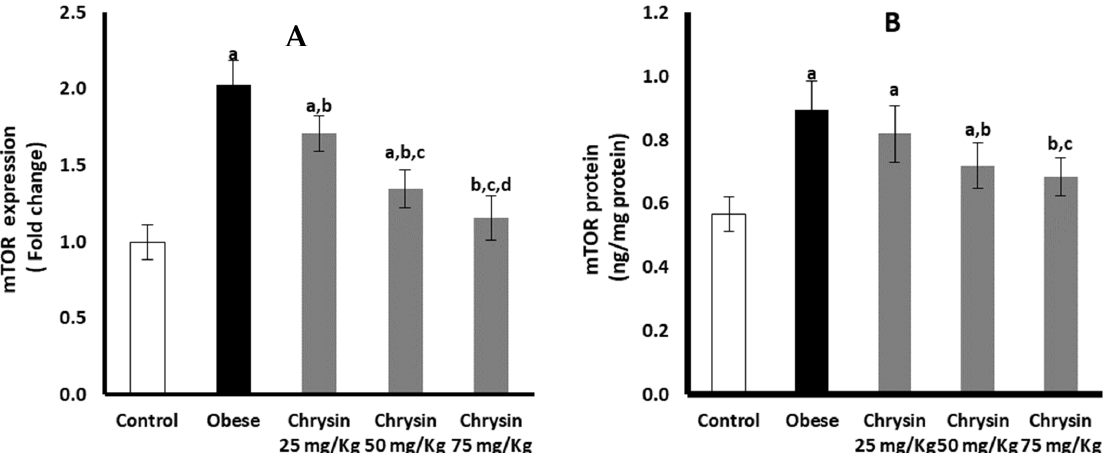
Figure 7. Changes in the hepatic expression of mTOR at mRNA ( A ) and protein ( B ) levels in the obese rats untreated or treated with different doses of chrysin. Data presented as Mean ± SD. a, significantly different from the control group; b, significantly different from the obese group; c, significantly different from the group treated with chrysin 25 mg/kg; d, significantly different from the group treated with chrysin 50 mg/kg, using ANOVA and p < 0.05.